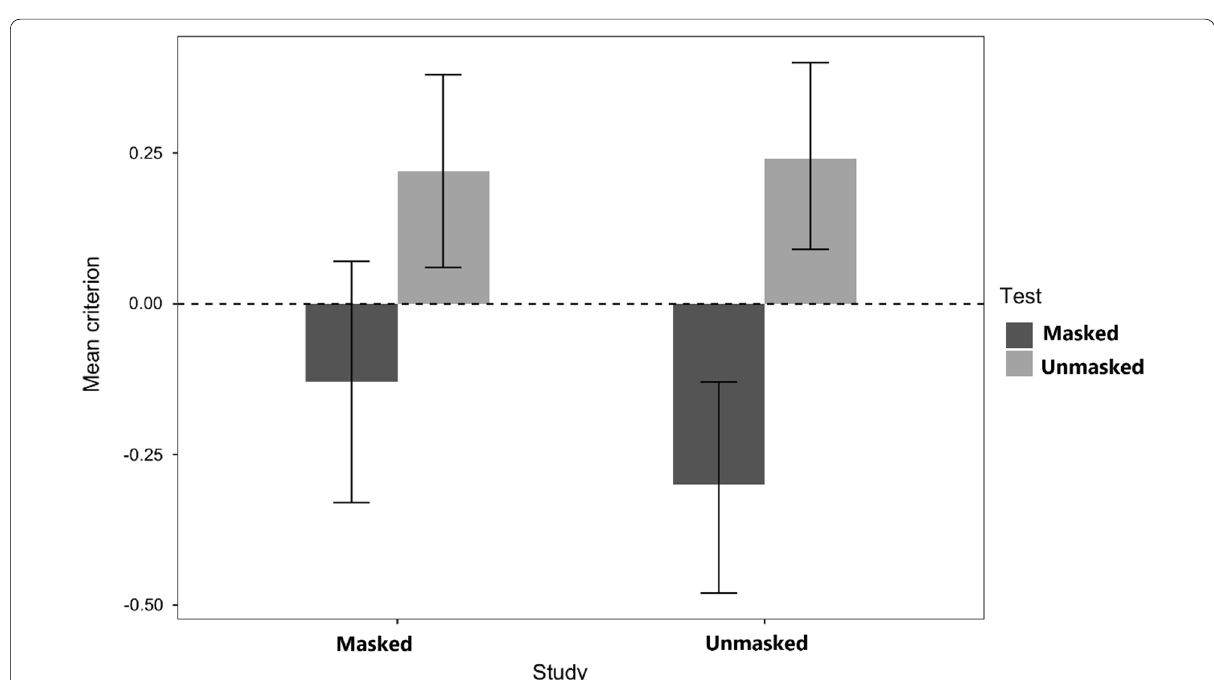
Fig. 6 Experiment 2: Criterion c. Note . Mean response criterion used by all participants regarding faces studied with and without a mask and subsequently tested with or without a mask (Experiment